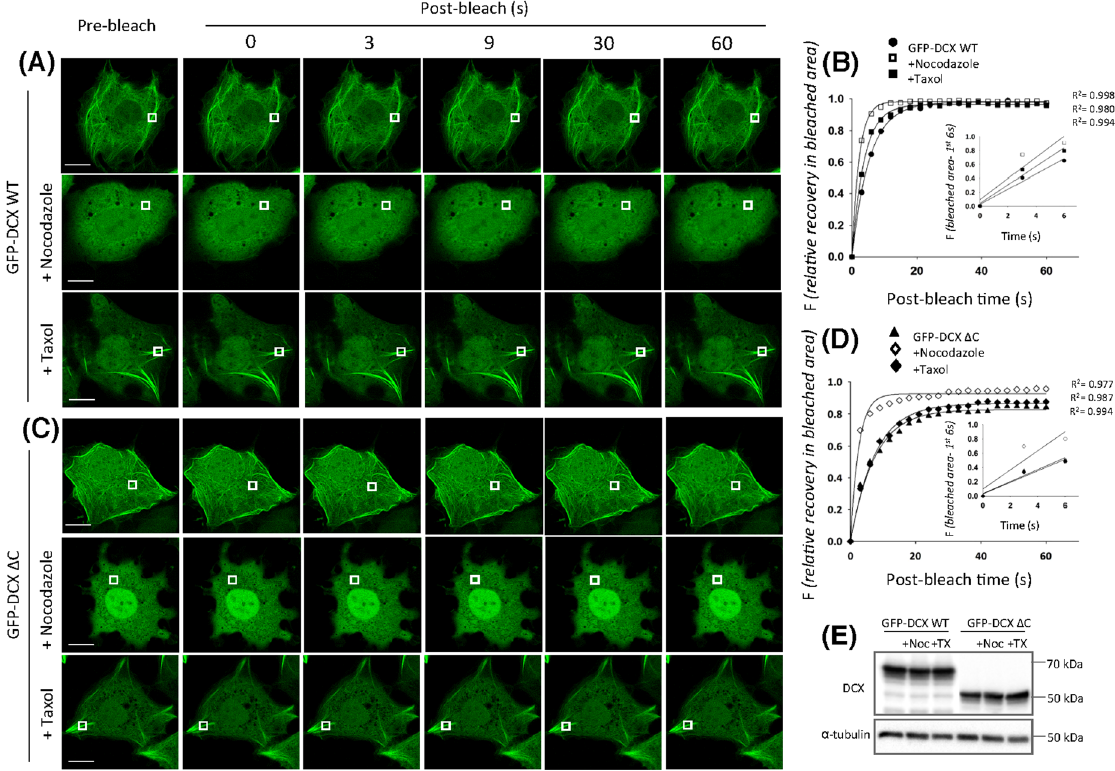
Figure 3. FRAP analysis reveals that GFP-DCX dynamics can be influenced by agents that alter MT stability. COS-1 cells were transfected to express ( A ) GFP-DCX WT or ( C ) GFP-DCX Δ C. Cells were exposed to nocodazole (20 µ M, 2 h) to depolymerise MTs or to taxol (10 µ M, 1 h) to stabilize MT polymers. A small ROI (indicated by white rectangle in each cell image) was photobleached in ( A ) and ( C ) and the fluorescence recovery was subsequently monitored post-bleach at 3 s intervals for 60 s. Plots of the recovery of fluorescence in the small area of bleach for ( B ) DCX WT and ( D ) DCX Δ C constructs before and after nocodazole or taxol treatments are shown. Regression values for the accuracy of each curve fit are indicated. The insets represent the initial recovery of fluorescence in the photobleached area for first three time-points (0–6 s of post-bleach) with the line of best fit used for the calculation of the initial recovery rates. ( E ) Equivalent expression of the GFP- DCX constructs was detected in the presence and absence of nocodazole or taxol by immunoblotting for DCX (upper panel), with equivalent protein loading detected by immunoblotting for total α -tubulin (lower panel). Scale bars represent 10 µ m. See Fig. 4 for quantitative pooled